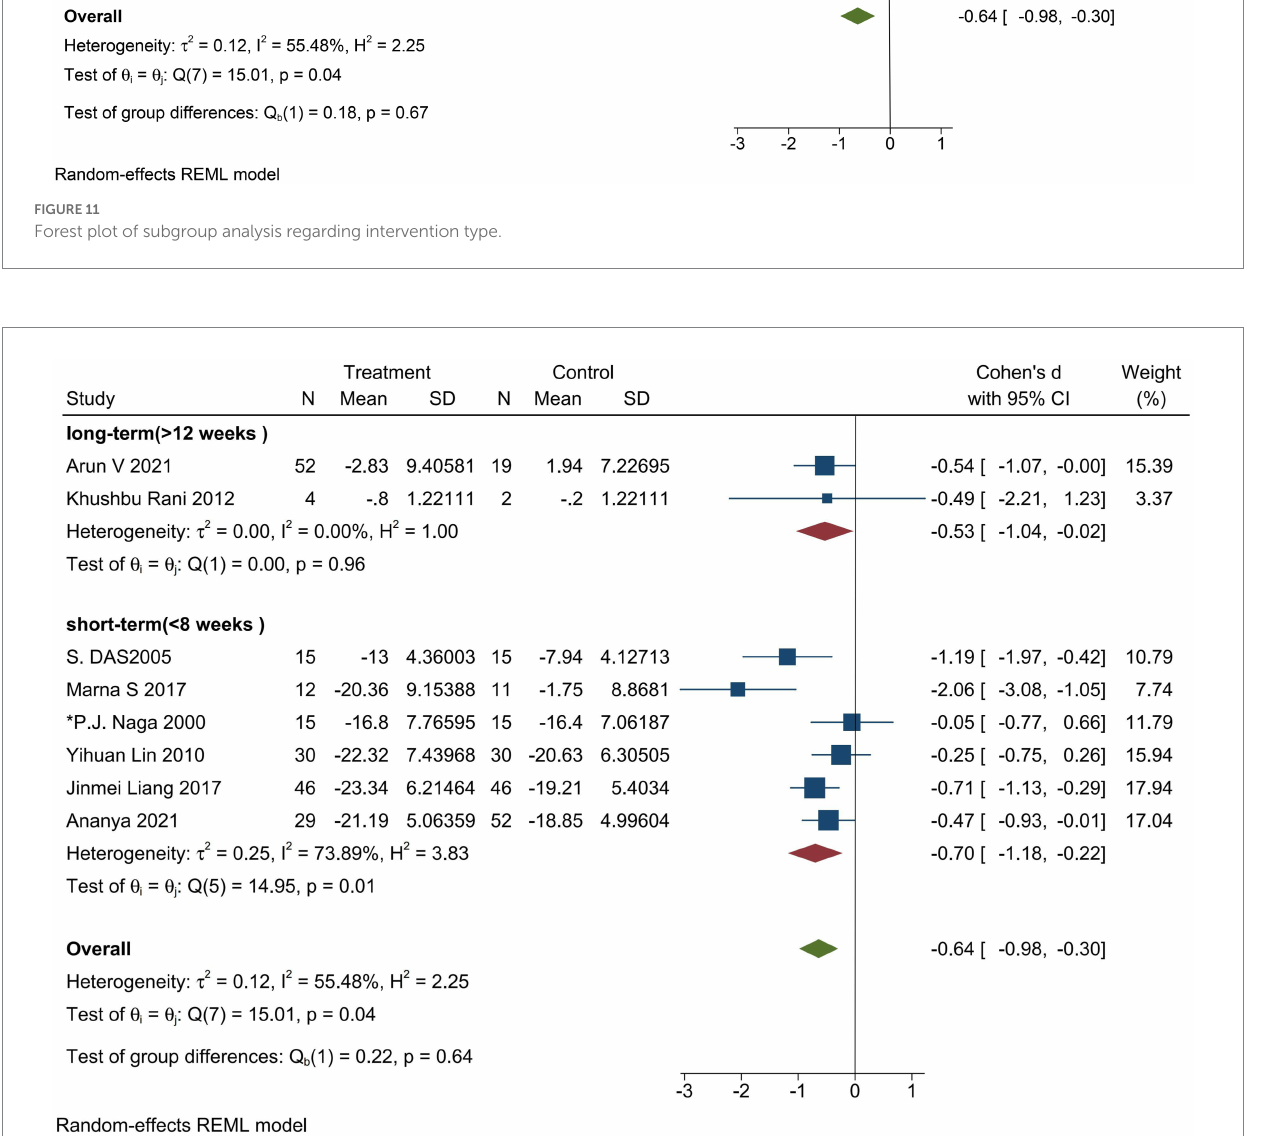
FIGURE 12 Forest plot of subgroup analysis regarding intervention duration.